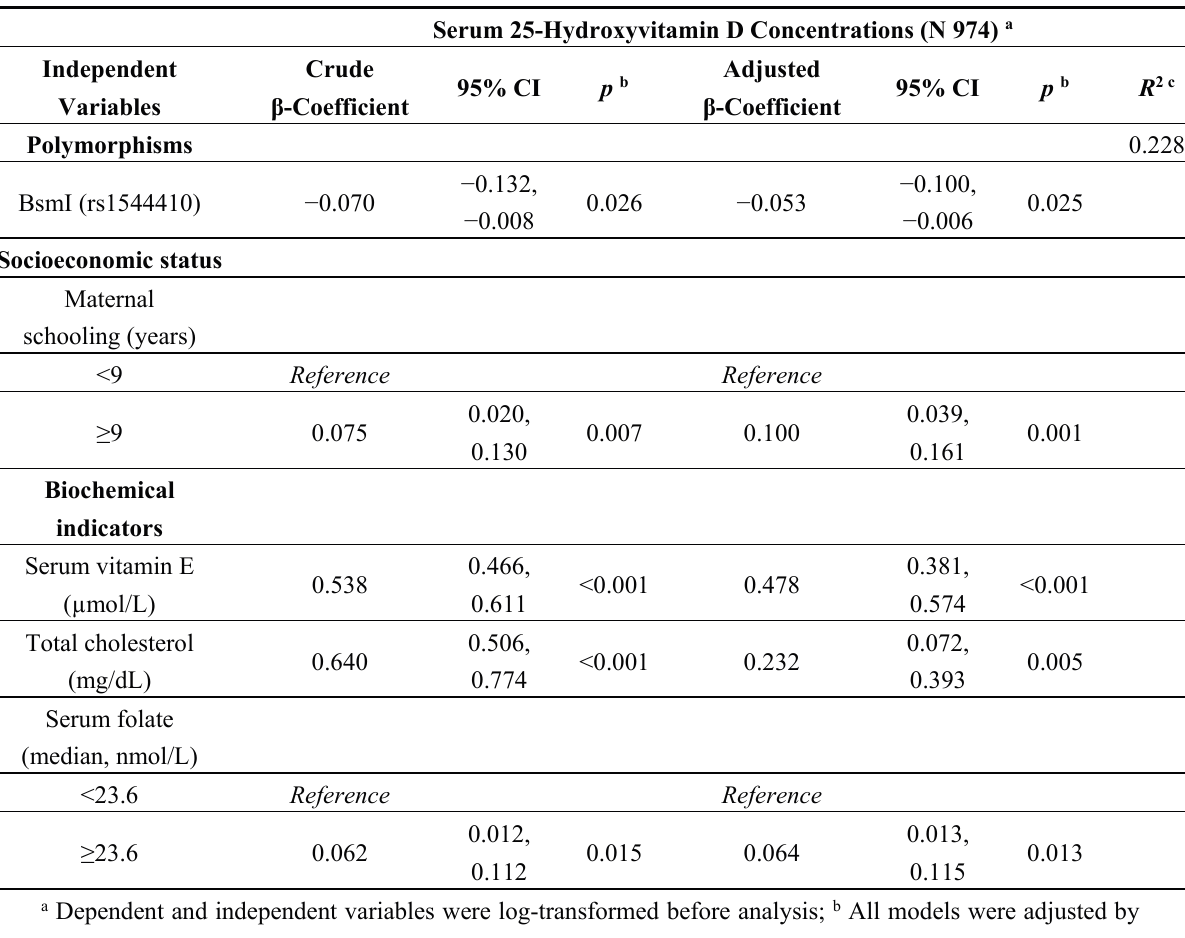
Table 3. Factors associated with serum 25-hydroxyvitamin D concentrations in urban Amazonian children <10 years old (Acrelândia, Brazil,